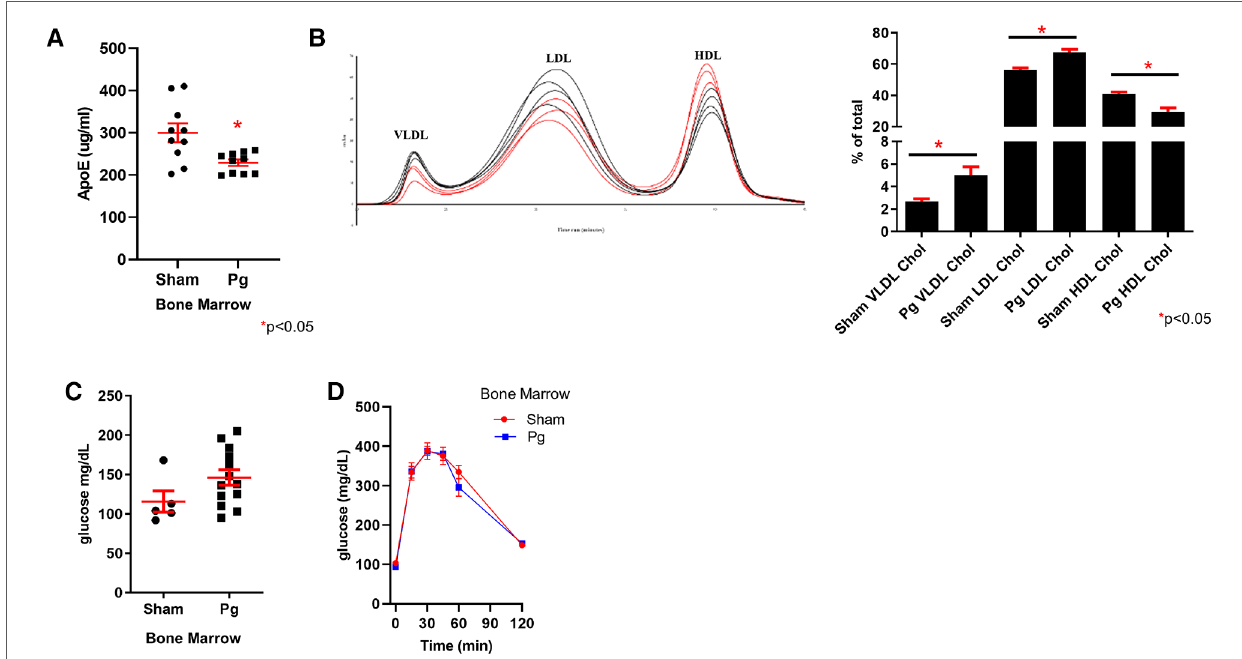
FIGURE 6 ( A ) ELISA for apoE in plasma from male mouse recipients of sham or Pg BM ( n =10/group). ( B ) Chromatographs of FPLC separation of lipoproteins and cholesterol analysis from male mouse recipients of sham or Pg BM ( n =3 sham; n =4 Pg ). Quanti fi cation of peaks as the percent of the total is shown adjacent. ( C ) Fasting glucose and ( D ) glucose tolerance testing of male mouse recipients of sham or Pg BM ( n =4 sham; n =5 Pg